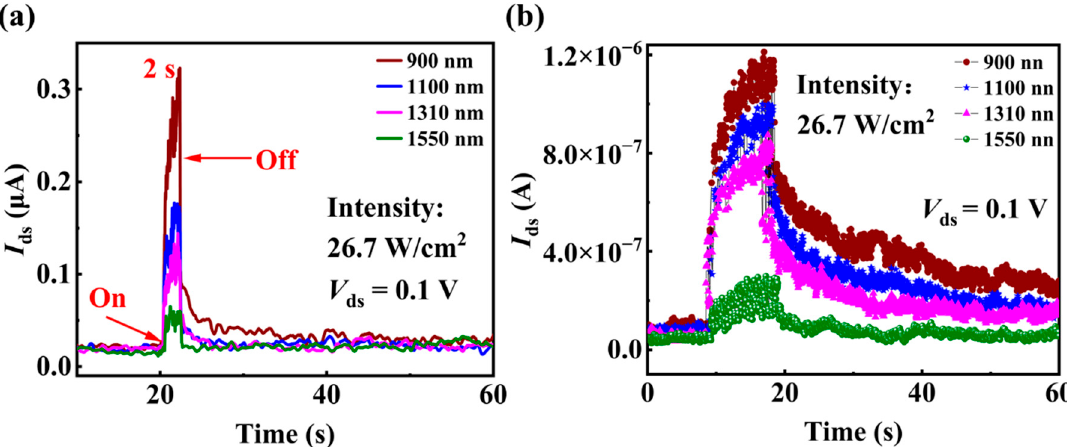
Figure 8. ( a ) The EPSCs response to NIR lights with different wavelengths but the same intensity of 26.7 W/cm 2 . ( b ) The EPSCs response to 20 light pulses with different wavelengths. Table 1. A summary of recently published NIR light